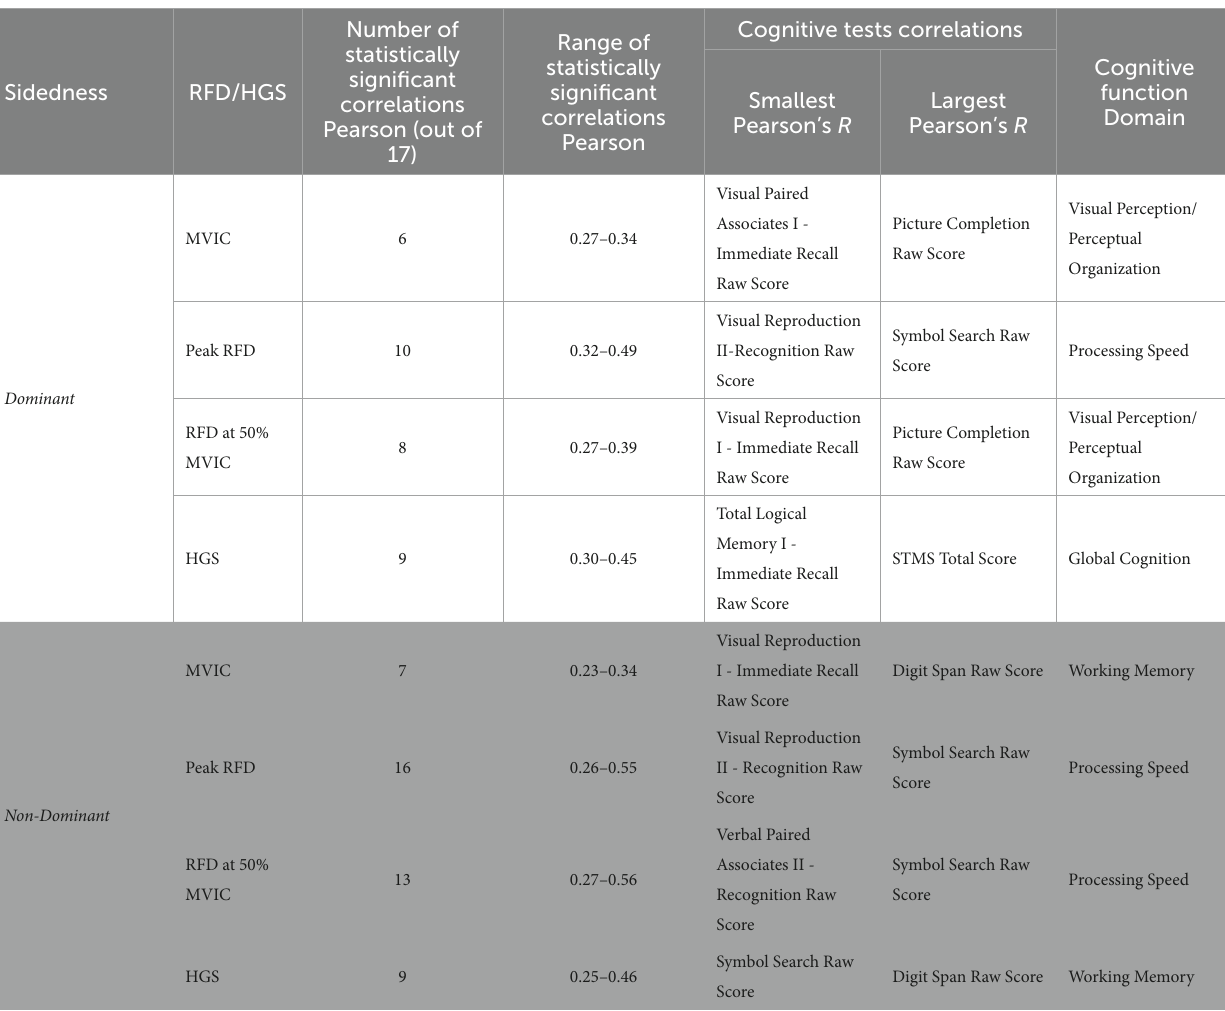
TABLE 2 Overall summary of all correlation based on